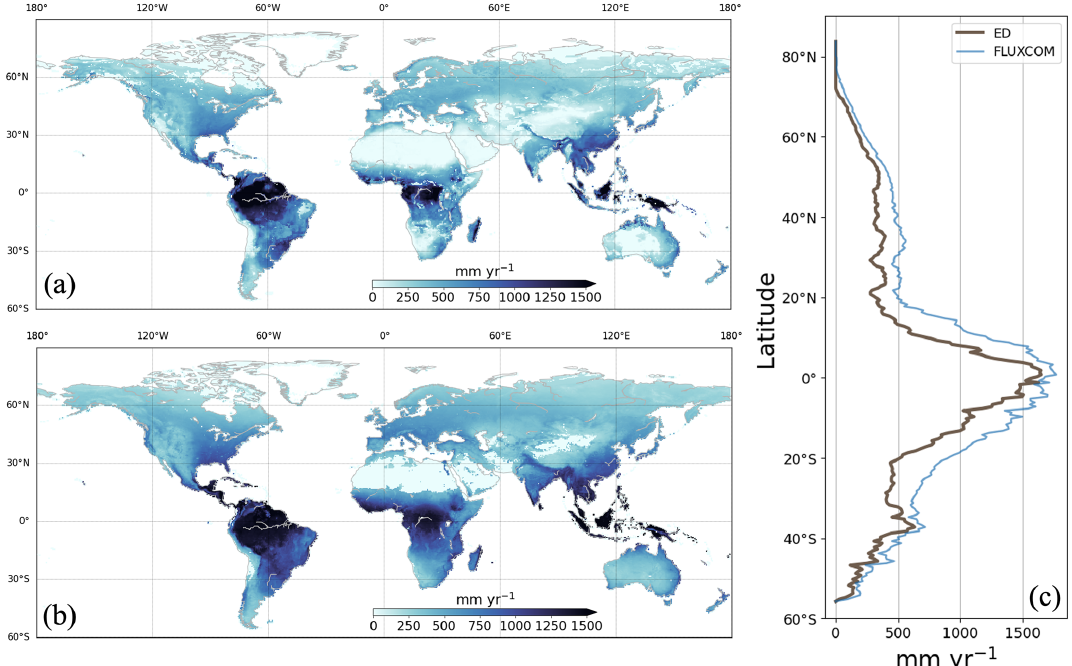
Figure 11. Average annual ET between 1981 and 2016 from ED (a) and FLUXCOM (b) , with a comparison of the corresponding latitudinal averages (c)